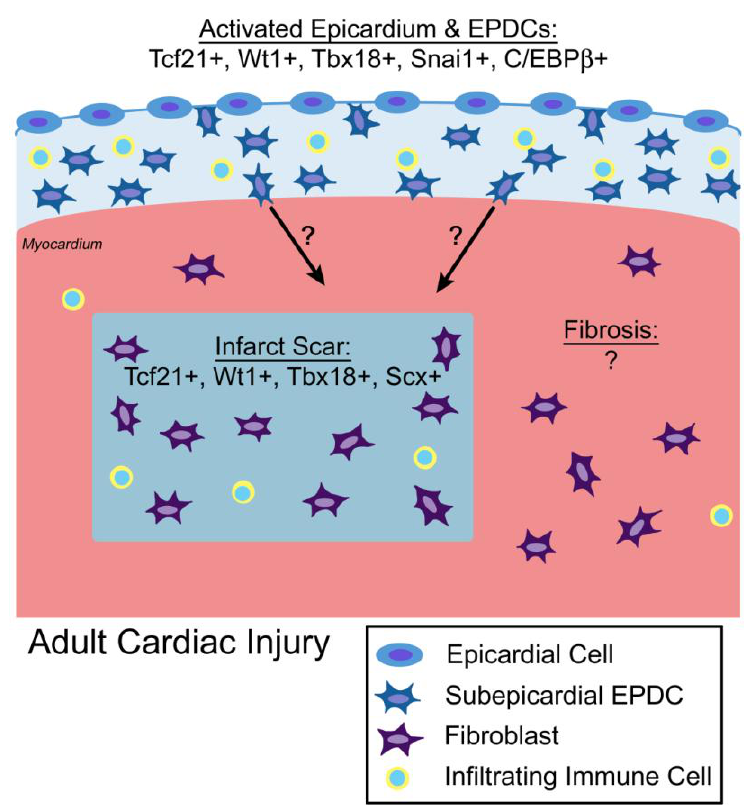
Figure 2. Model depicting epicardial cell reactivation and expression of transcription factors, including Tcf21, Wt1, Tbx18, Snai1, and C/EBP (cid:69) , following myocardial infarction (MI) in the adult heart. Activated epicardial cells undergo EMT and invade the subepicardial space following MI. The ultimate fate of activated EPDCs and their ability to invade the myocardium in the infarcted heart has not yet been fully characterized. In the area of the infarct scar Tcf21, Wt1, Tbx18, and Scleraxis (Scx) also are expressed, and immune cells are present in the activated epicardium and fibrotic scar. Currently, it has not been reported whether epicardial transcription factors are activated in other forms of cardiac fibrosis. See text for details and